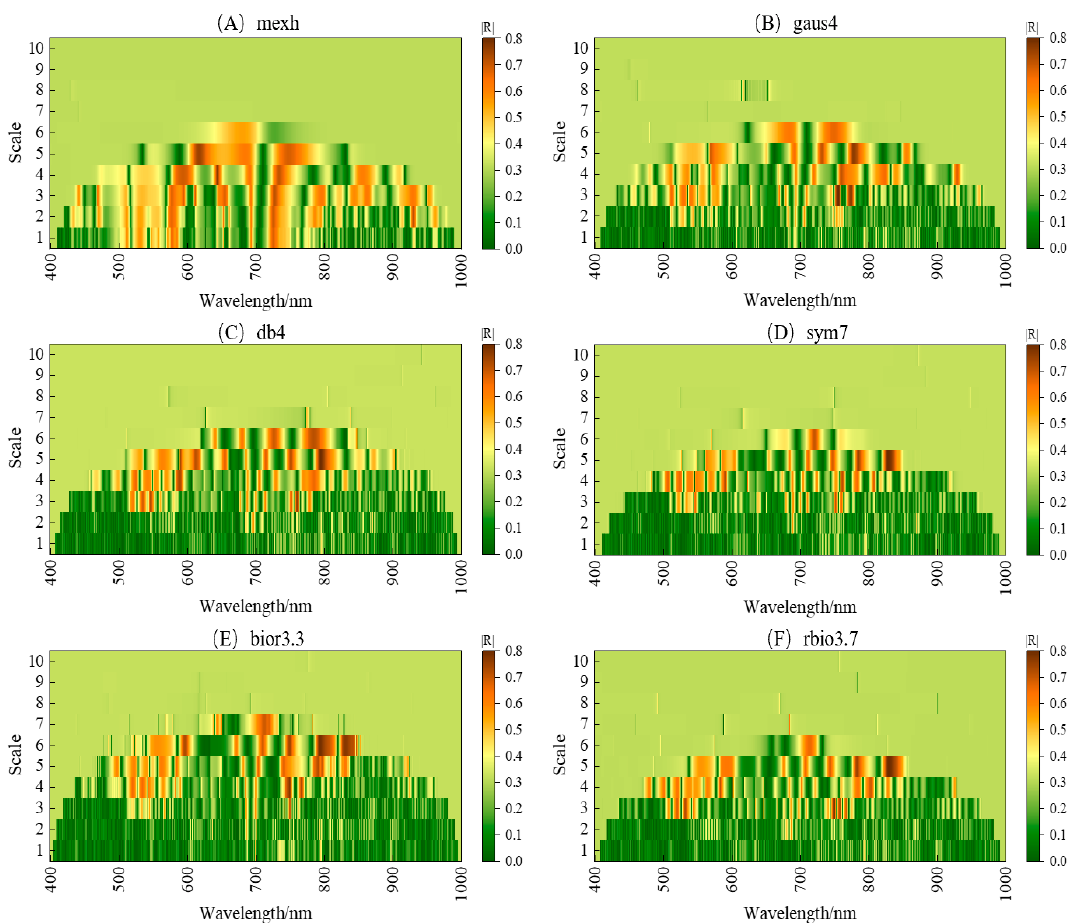
Figure 5. Correlation between wavelet coefficients and Fv/Fm based on different mother wavelet functions. ( A ) mexh, ( B ) gasu4, ( C ) db4, ( D ) sym7, ( E ) bior3.3, ( F ) rbio3.7. Table 4. |R| of Fv/Fm with WCs.